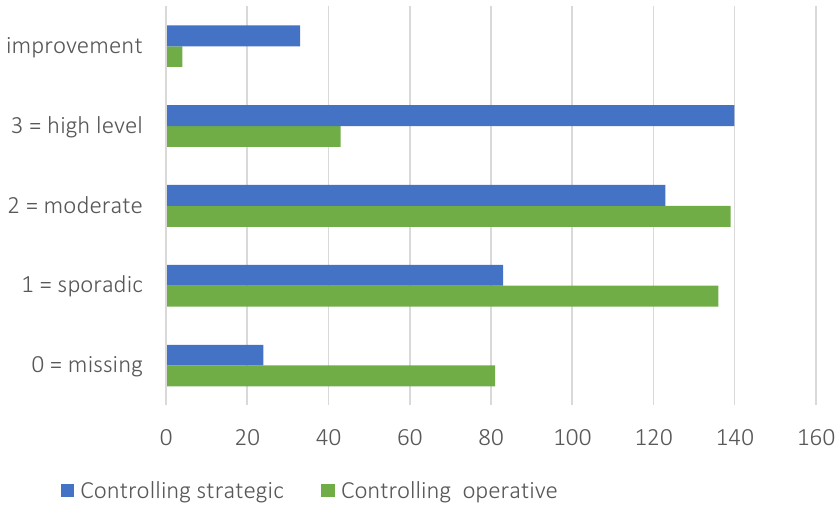
Figure 1. Operative and strategic controlling implementation at the surveyed